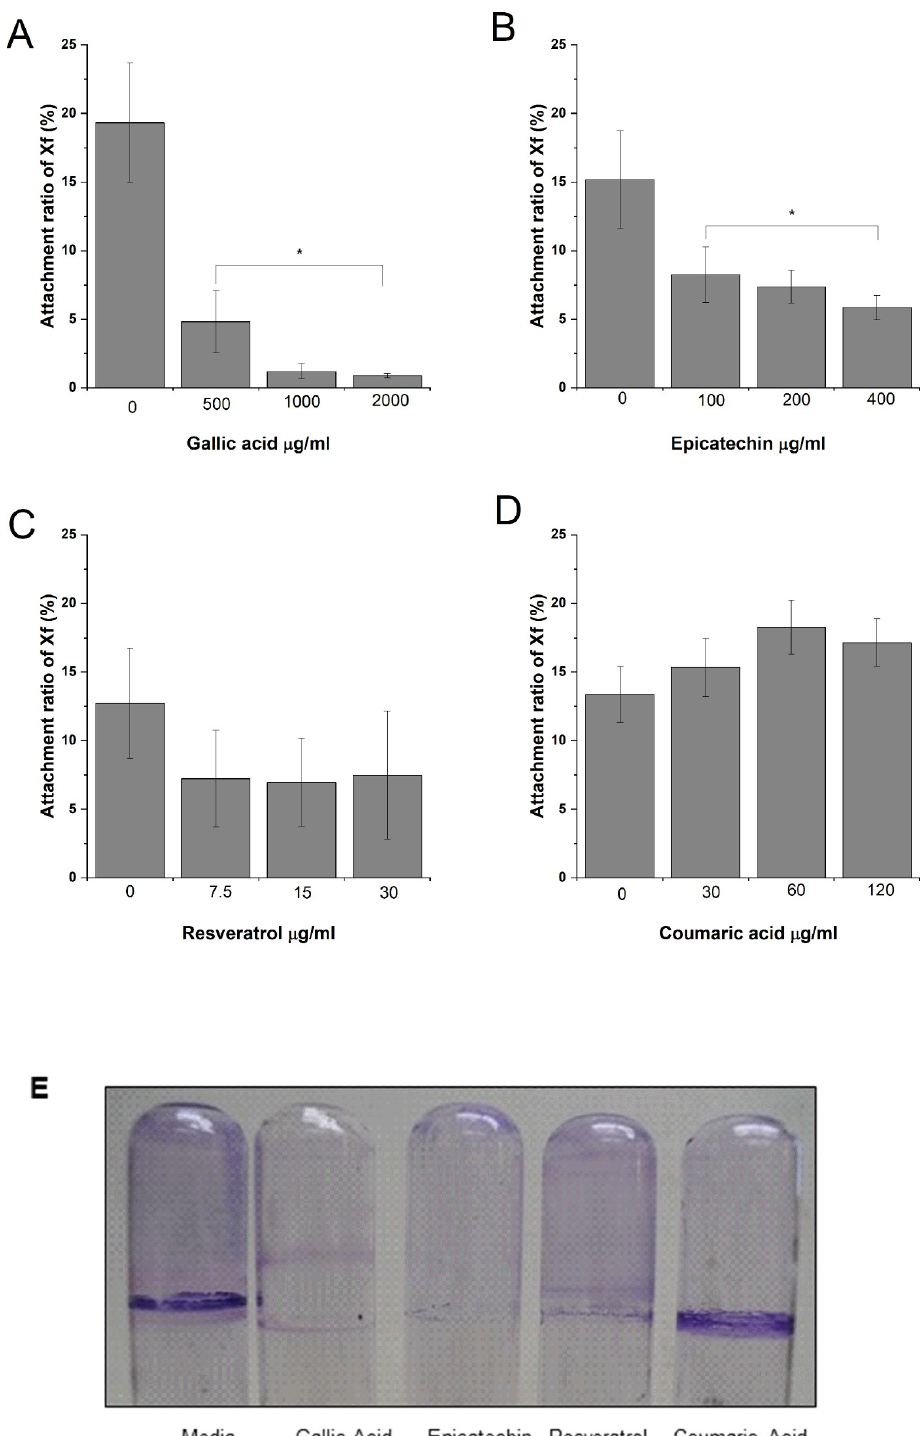
Fig 1. Gallic acid and epicatechin inhibit cell surface attachment. Quantitative cell-surface attachment of X . fastidiosa cultivated in liquid medium supplemented with GA (gallic acid, A), EP (epicatechin, B), RES (resveratrol, C), and CA (coumaric acid, D). Biofilm formation of cells grown with different treatments in polystyrene tubes (E). Data are expressed as mean ± standard deviation of three independent experiments ( n = 8 replicates per experiment). Asterisk indicates significant differences (p-value < 0.005) in attachment ratio as determined by One-way ANOVA followed by Dunnett’s test comparing treatments to the media